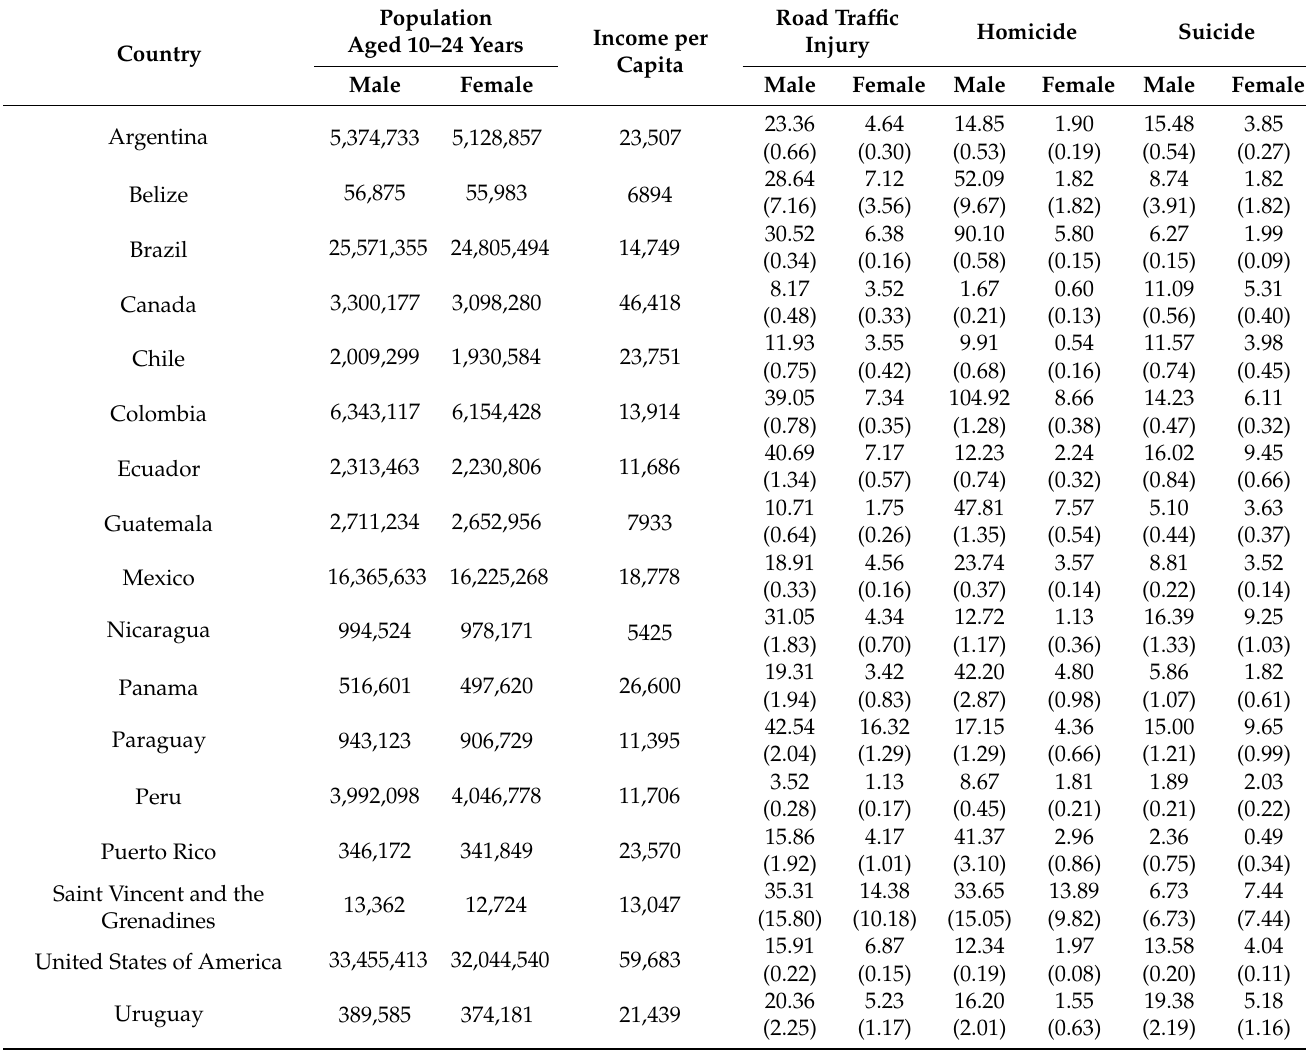
Table 1. Age-adjusted mortality rates (per 100,000 pop) due to road traffic injury, homicide, and suicide in young (10–24 years old) males and females, reference population and average income per capita. Selected countries of the Americas,